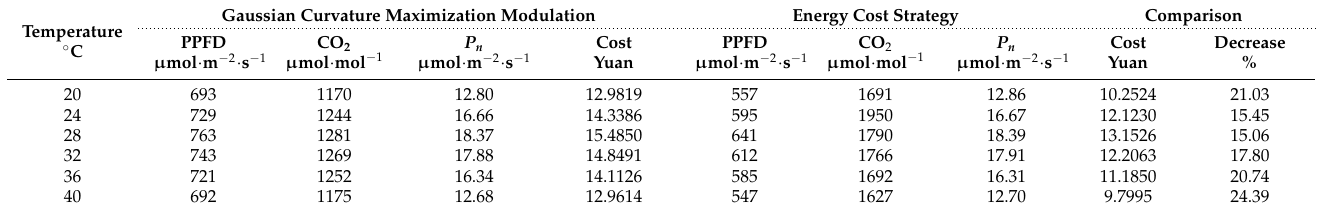
Table 3. Comparison of Gaussian curvature maximization modulation and energy cost strategy. Gaussian Curvature Maximization Temperature ◦ C